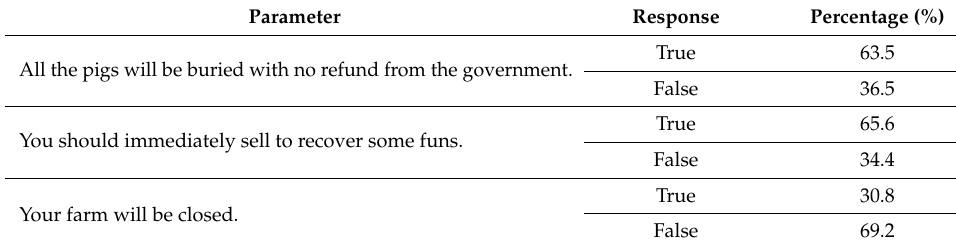
Table 11. Reasons for farmers not reporting a case of ASF. Parameter Response Percentage (%)